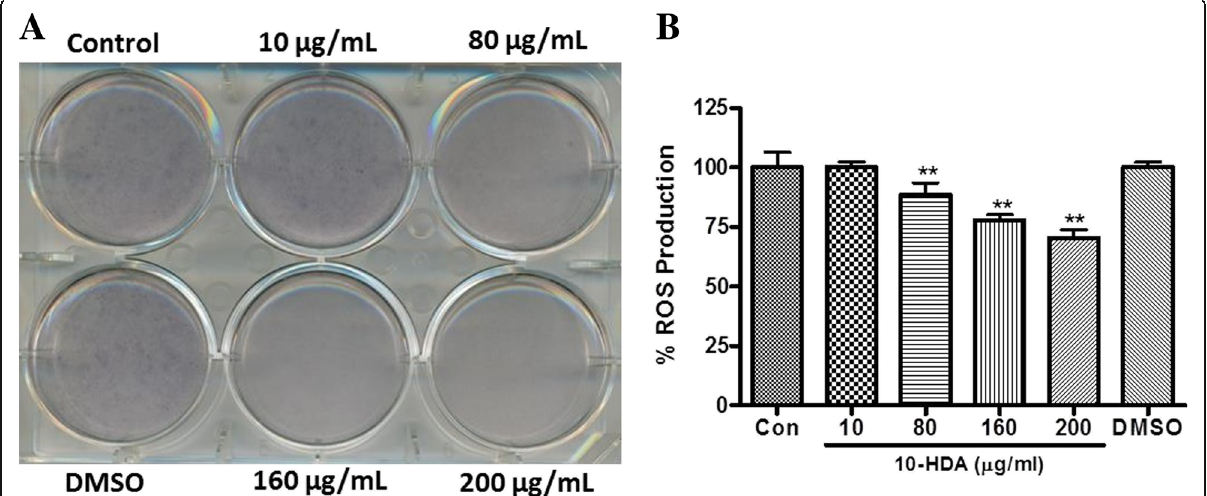
Fig. 7 Effect of 10-HDA on ROS production during 3 T3-L1 adipocyte differentiation. a Visualization was conducted for the NBT stained cells which were treated with 10-HDA. b The ROS production was quantified as percent of control. The ROS productions are presented as means ± SD of triplicate experiments. Statistical significance was calculated using one-way ANOVA followed by Dunnett ’ s multiple comparisons test.